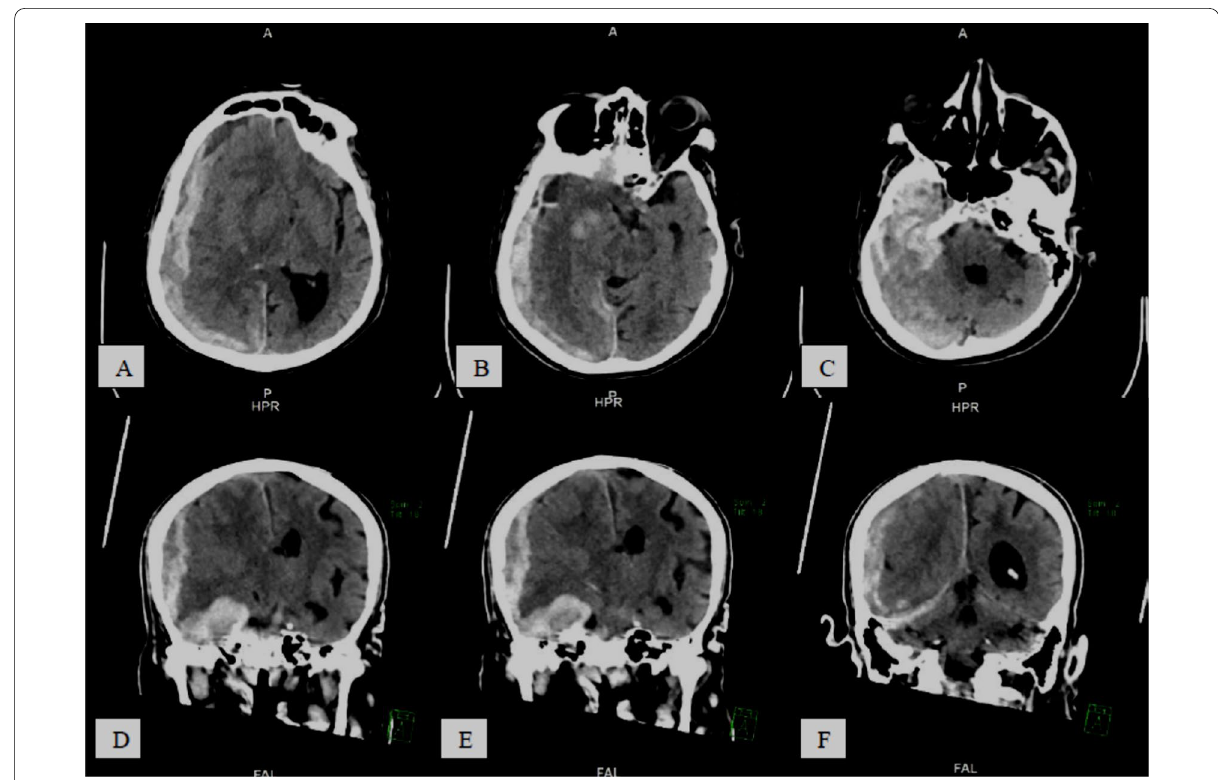
Fig. 3 88-year-old COVID-19 male patient with sudden onset of left sided weakness and syncopal attack, under umbrella of anticoagulant, A–C and D–F serial axial and coronal CT images, respectively, show right fronto-temporo-parital extra-axial acute on top of chronic subdural hematoma with mid line shift, sub-falcine and uncal